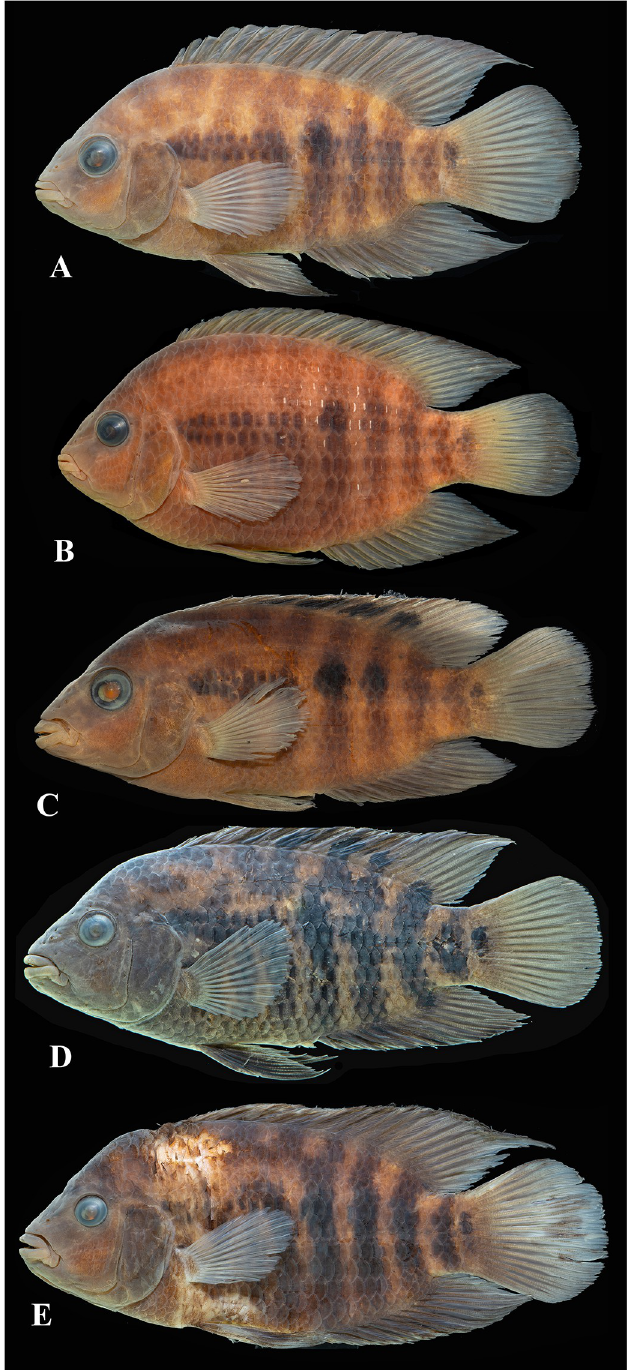
Fig 19. Australoheros acaroides. A . Adult male, 73.6 mm SL; MCP 18658; Brazil: Cachoeira do Sul: on road between Candela´ria and Cachoeira do Sul. B . adult female, 92.8 mm SL; MCP 9221; Brazil: Rio Grande do Sul; Restinga Seca: va´rzea of Rio Jacuı´on road Santa Maria–Vera Cruz. C . Adult female, 58.5 mm SL; MCP 26548; Brazil: Rio Grande do Sul: Nova Palma: Rio Jacuı´basin: Arroio Caembora´ close to Caembora´, reversed. D. Adult female, 77.2 mm SL.; MCP 49694; Brazil: Rio Grande do Sul: Bom Jesus: Rio Pelotas basin: stream tributary of the Rio dos Touros ca 4 km NE of BR 285 (secondary road). E. Adult male, 88.5 mm SL; MCP 26772; Brazil: Rio Grande do Sul: S ã o Francisco de Paula: Rio Tainhas basin: Arroio Ribeir ã